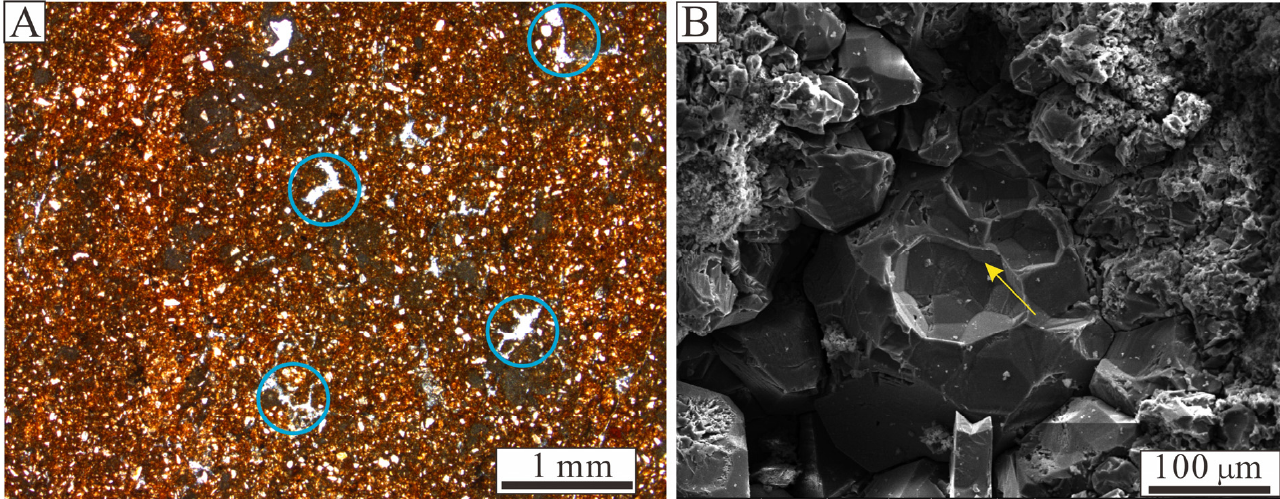
Figure 5. Detailed morphology of rhizoliths of the Yaojia Formation in rock samples. ( A ) Rhizoliths in reddish silty mudstone under plane polarized light (marked by blue circle), ( B ) SEM photomicrograph of euhedral analcime in rhizoliths